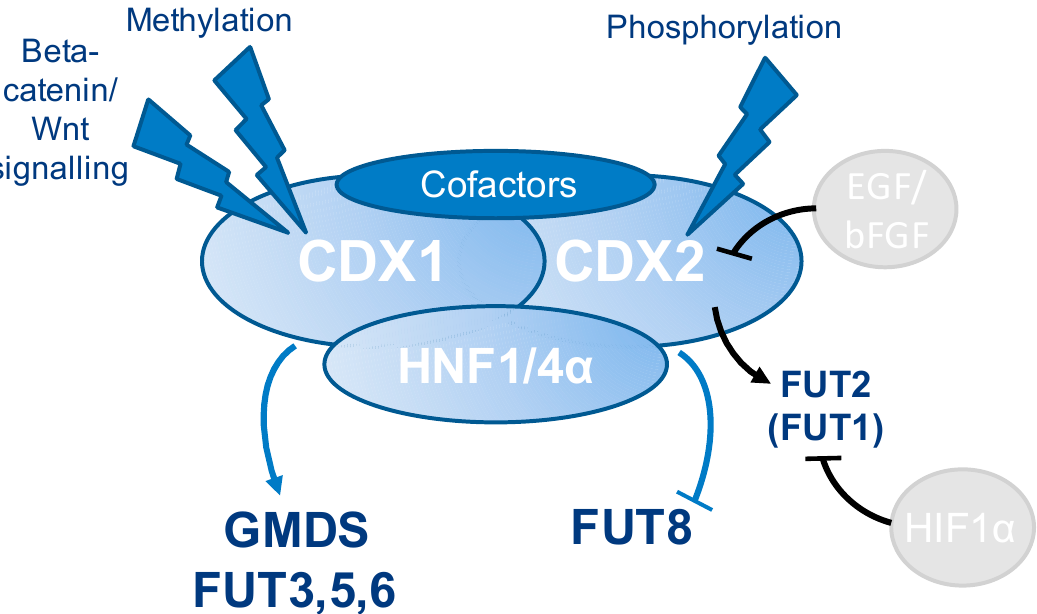
Figure 6. Model for regulation of fucosylation. Based on our findings as well as reports from literature (Lauc, G. et al. (2010) PLoS Genet 6 ; Guo, R. J., Suh, E. R. & Lynch, J. P. (2004) Cancer Biol Ther 3 , 593-